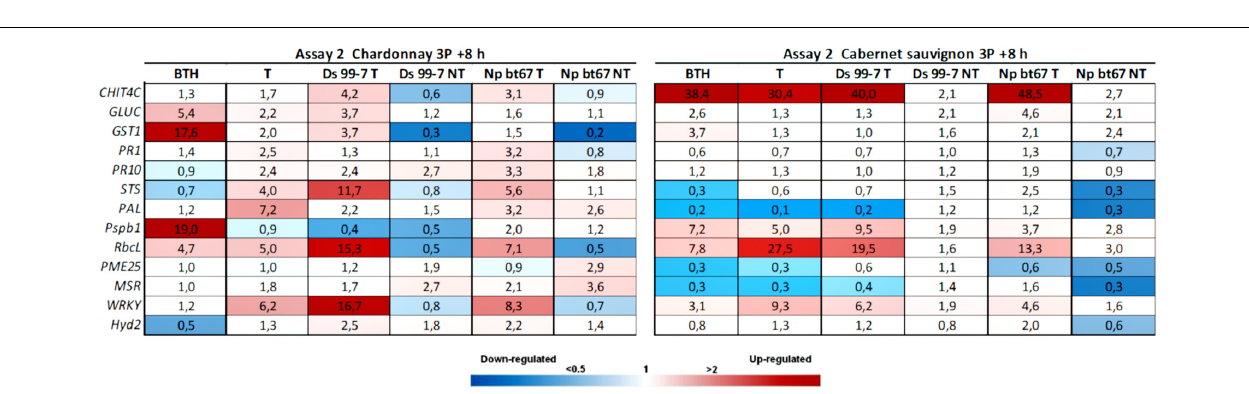
FIGURE 4 | Expression levels of the selected 13 genes recorded by RT-qPCR in “Chardonnay” and “Cabernet sauvignon” 8 h after the third LC2017 treatment (3P) in Assay 2. Values (mean of three technical replicates) represent the expression levels ( (cid:49)(cid:49) Ct) of reported conditions relatively to the control (NT). Expression of a given gene was considered up- or down-regulated when value of relative expression was > 2-fold or < 0.5-fold compared to the control,